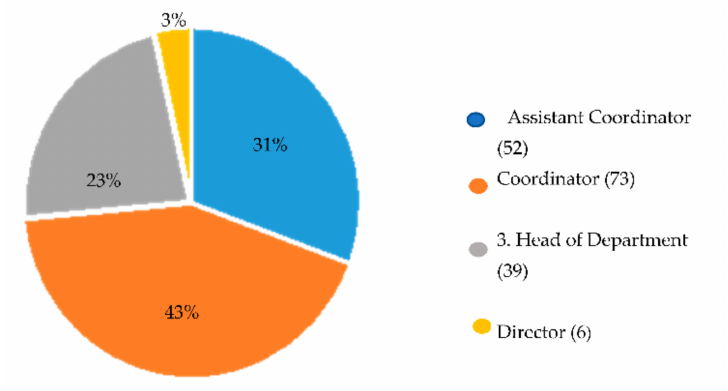
Figure 8. Participation by type of position. Source: self-made.